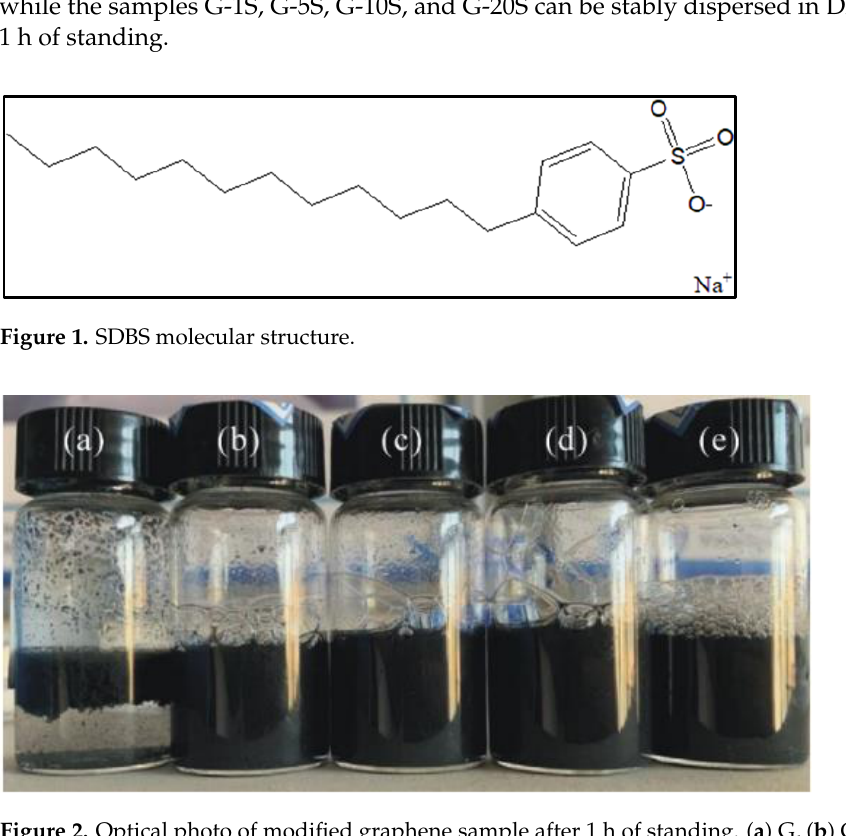
Figure 2. Optical photo of modified graphene sample after 1 h of standing. ( a ) G, ( b ) G-1S, ( c ) G-5S, ( d ) G-10S, and ( e ) G-20S.